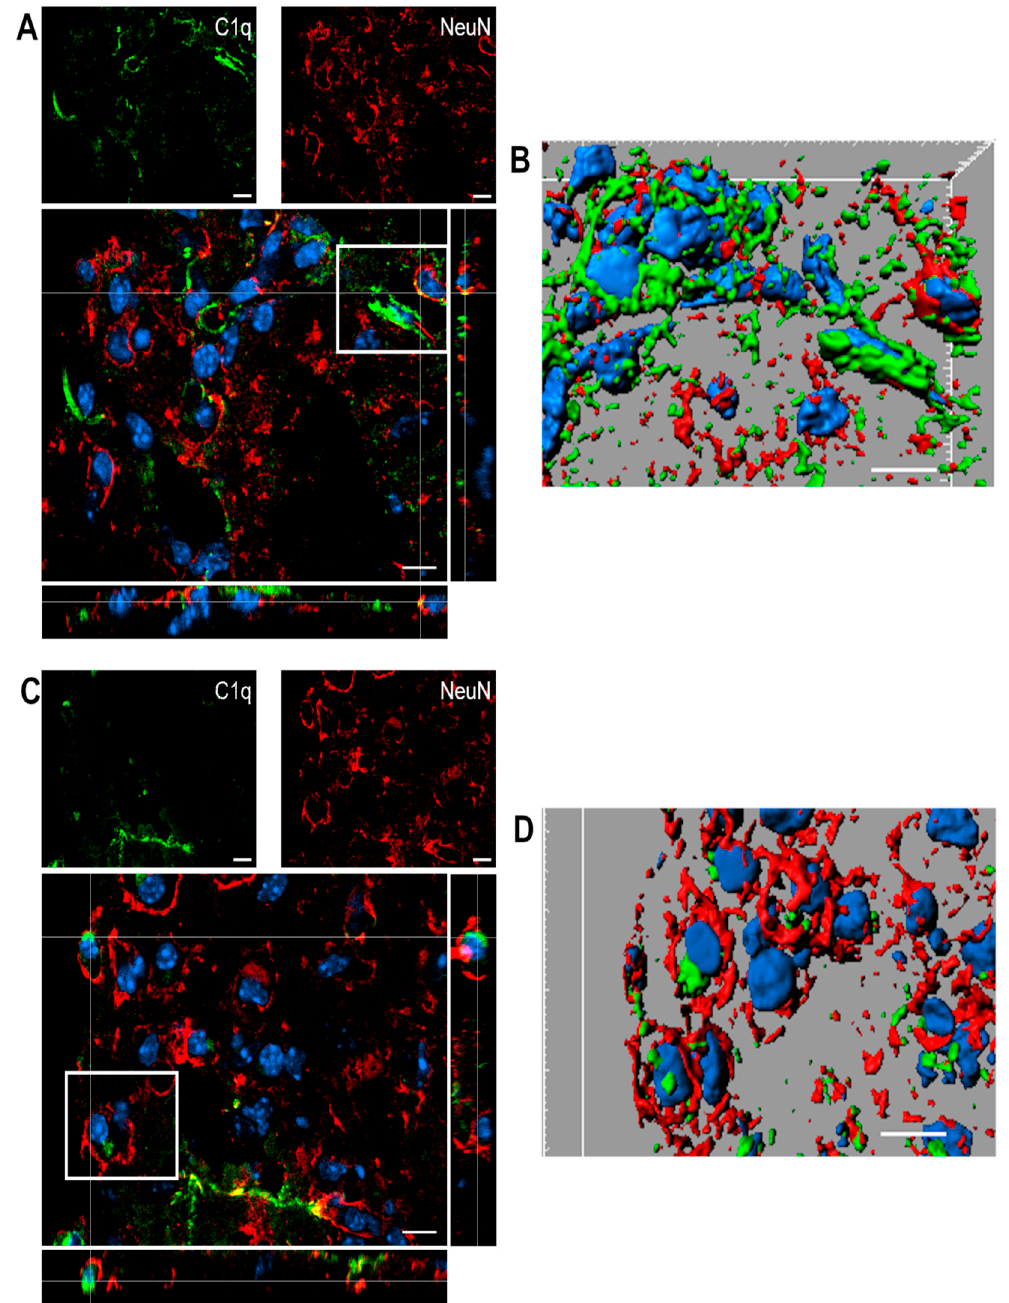
Figure 8. ( A – D ). Confocal analysis of C1q and neuron reciprocal localization in the contused cortex 96 h after TBI. ( A , C ) C1q (green) is present along the border of the lesion close to neurons (NeuN, red). C1q frequently localizes in close proximity to neurons. ( B – D ) Three-dimensional image rendering shows C1q colocalization with neurons, possibly driving apoptosis. Images are representative of at least two independent experiments. Nuclei are in blue. Scale bar = 10 μ m.